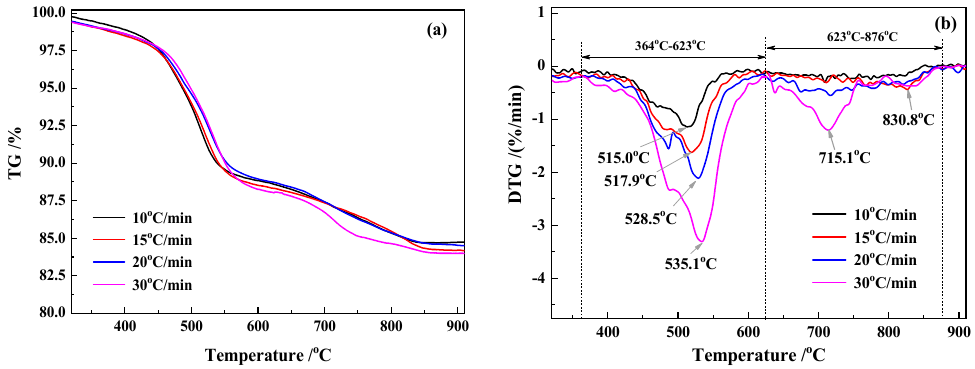
Figure 3. ( a ) TG and ( b ) DTG data of high-sulfur bauxite.